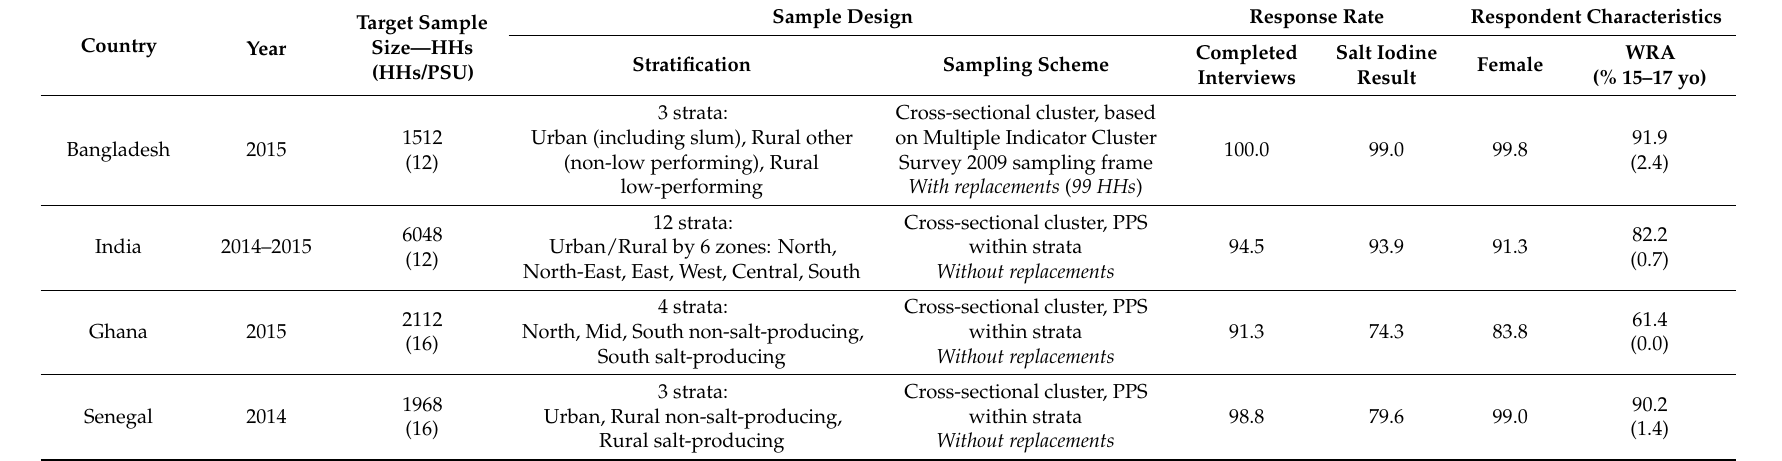
Table 1. Overview of the survey design, response rate and respondent characteristics for each